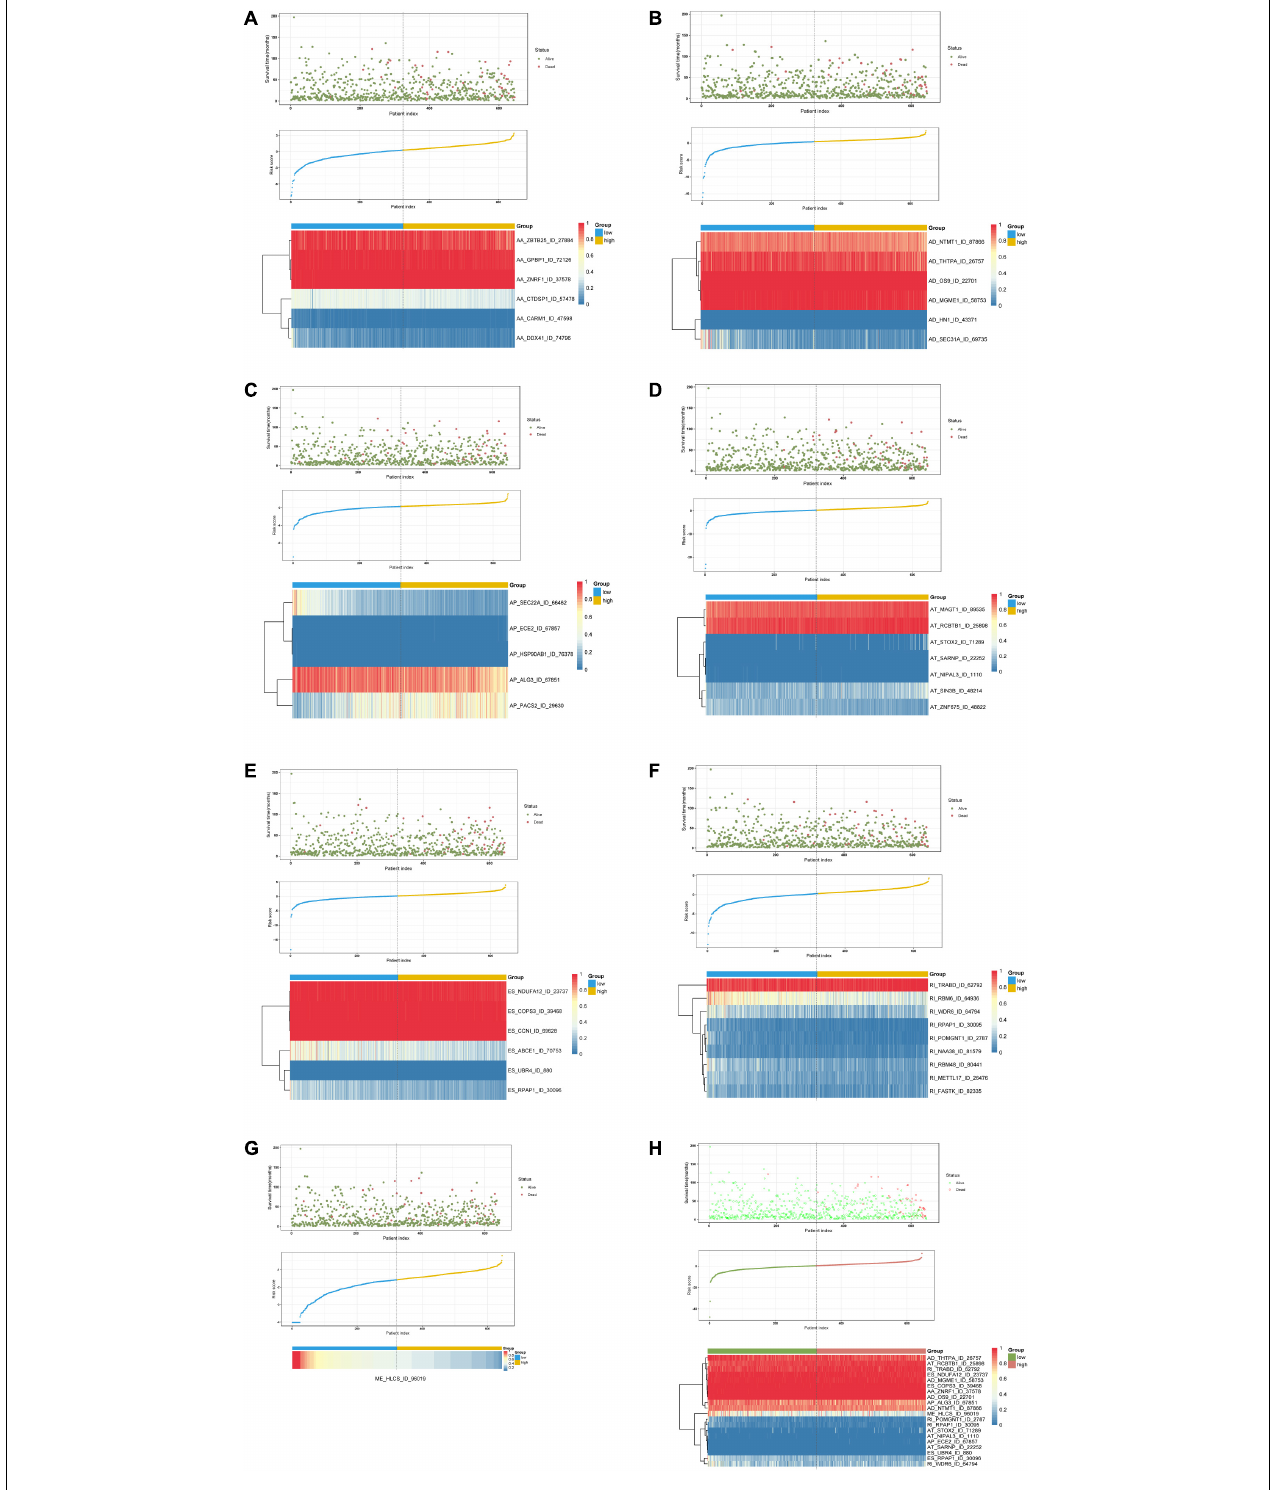
FIGURE 6 | Determination and analysis of the prognostic AS signatures in BRCA cohort. BRCA patients were divided into high- and low-risk subgroups based on the median cut of risk score calculated separately. The upper part of each assembly indicates distribution of patients’ survival status and survival times ranked by risk score, the middle part represents the risk score curve, and the bottom heatmap displays splicing pattern of the AS signature from each AS type or all seven AS types. Color transition from blue to red indicates the increasing PSI score of corresponding AS event from low to high. (A–G) Risk score (corresponding to each AS type) calculated and AS signature constructed using each AS type of prognostic splicing events. (H) Risk score (all) calculated and final AS signature constructed using all types of prognostic splicing events.